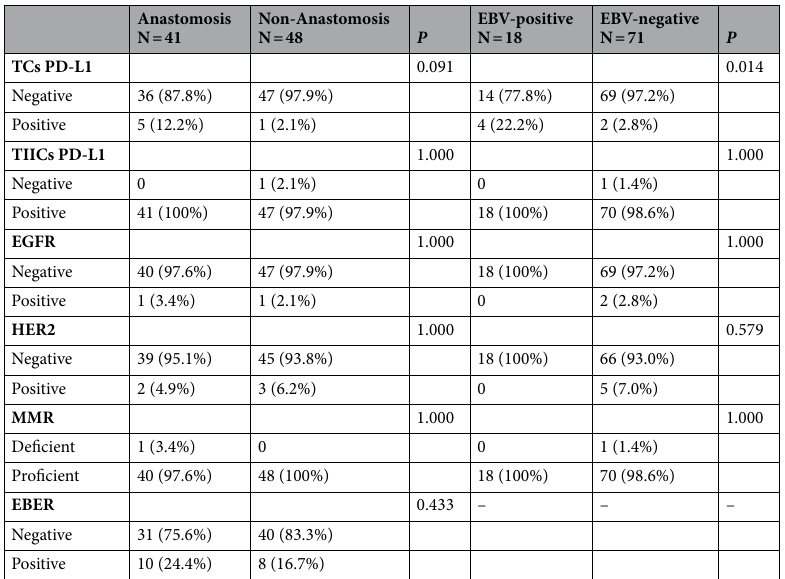
Table 5. Comparison of immunohistochemistry and in situ hybridisation between gastric stump cancer (GSC) located in the anastomotic site (Anastomosis) or others (non-Anastomosis) and GSC with EBV positivity or negativity. TCs tumour cells, TIICs tumour-infiltrating immune cells.